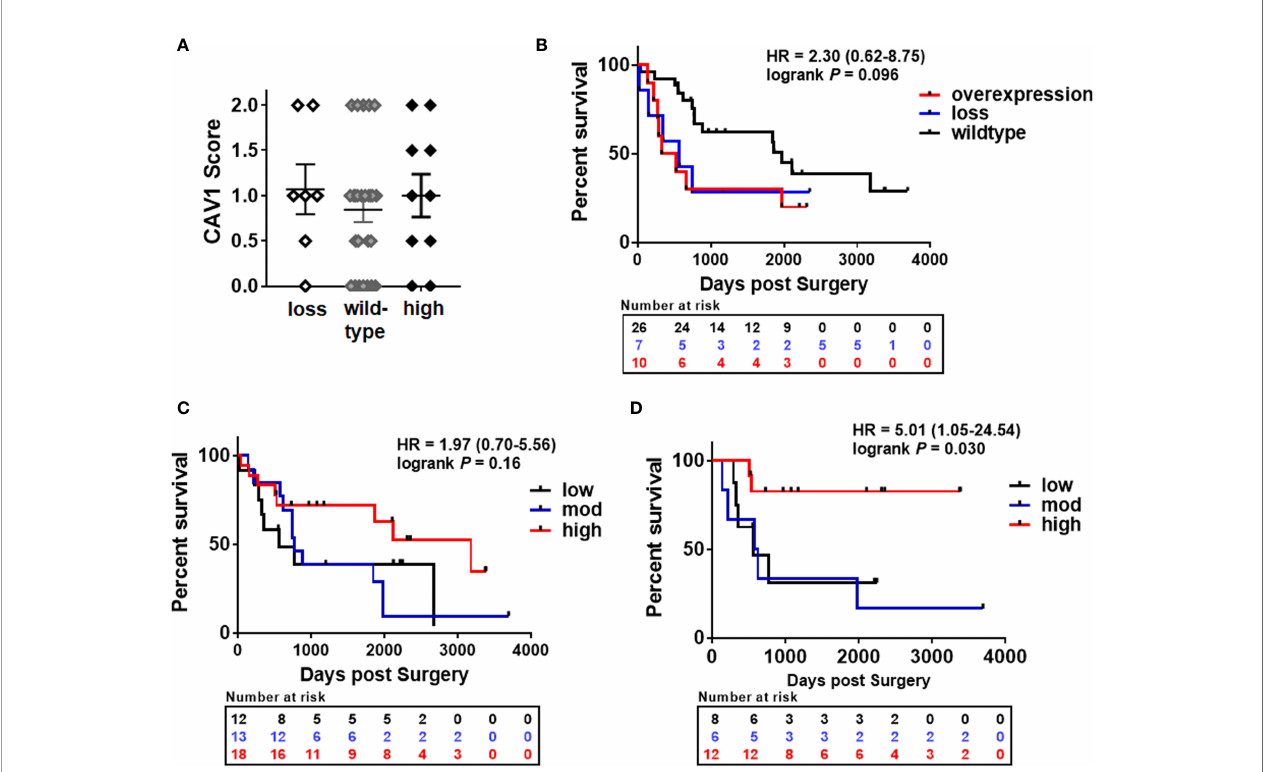
FIGURE 3 | Overall survival as related to and p53 expressions and according to the expression of stromal CAV1 in penile cancer. (A) Differential p53 expression levels were classi fi ed according to their CAV1 immunoreactivity score for low (0-0.5), moderate (>0.5-1.5), and high (>1.5-2) CAV1 expression levels of respective tumor cells (p53 overexpression n=10, p53 wild-type n= 26, p53 low n= 7). (B) Overall survival curves for patients according to the p53 expression in tumors. HR and log-rank P (wild-type: blue line versus loss: black line) are indicated. HR=2.28 (0.80-6.49) log-rank P=0.053 (overexpression: red line versus loss). (C) Overall survival curves for patients with low (n=12), moderate (n=13) and high (n=18) CAV1 content within the tumor stroma. HR and log-rank P (low versus high CAV1 levels) are indicated. HR=2.33 (0.92-5.91), log-rank P=0.056 (moderate versus high). (D) Overall survival curves for patients with p16-negative tumors and low (n=8), moderate (n= 6) and high (n=12) CAV1 content within the tumor stroma. HR and log-rank P (low versus high CAV1 levels) are indicated. HR=6.22 (1.21-32.02) log- rank P=0.0025 (moderate versus